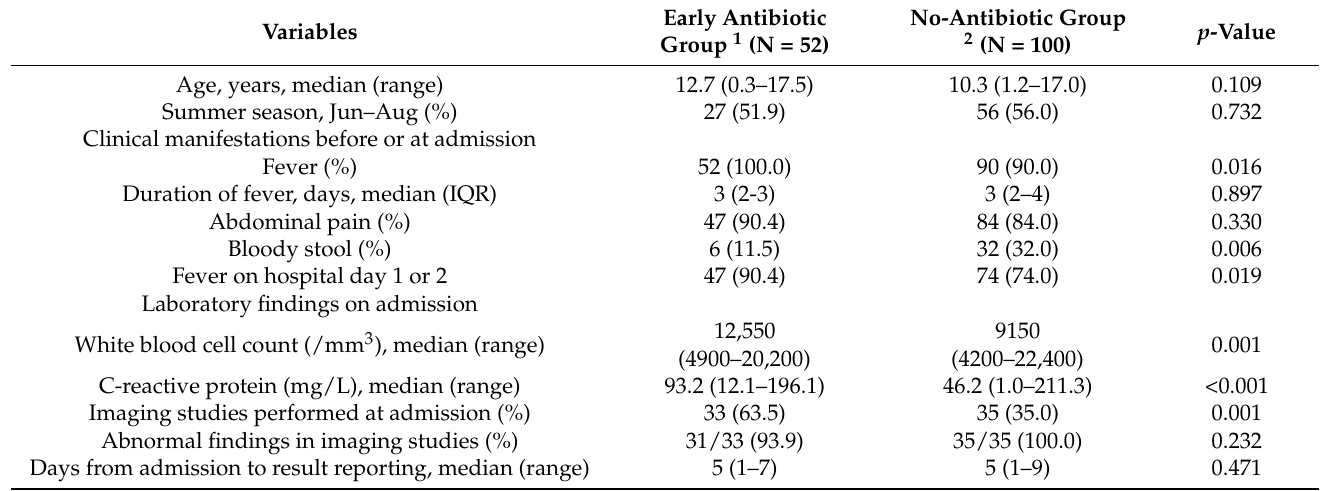
Table 3. Comparison between the early and no-antibiotic